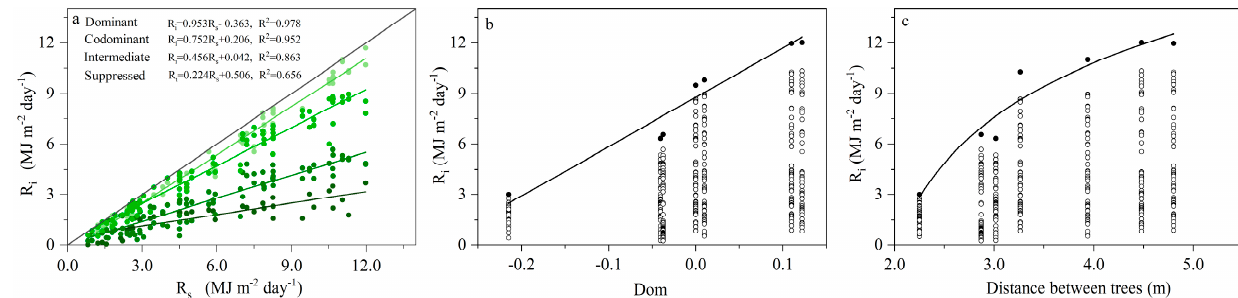
Figure 7. Effect of social positions on the solar radiation income of individual trees. ( a ) Response of R i to R s . ( R i represents the daily solar radiation income of individual trees; R s represents the daily solar radiation income outside the forest of the sample slope). ( b ) Response of R i to Dom ( Dom represents the social position levels of the sample trees). ( c ) Response of R i to D . ( D represents the mean distance between the sample tree and neighboring trees). The upper boundary line ( UBL ) method [44] was used to determine the response function types of R i to Dom and D .